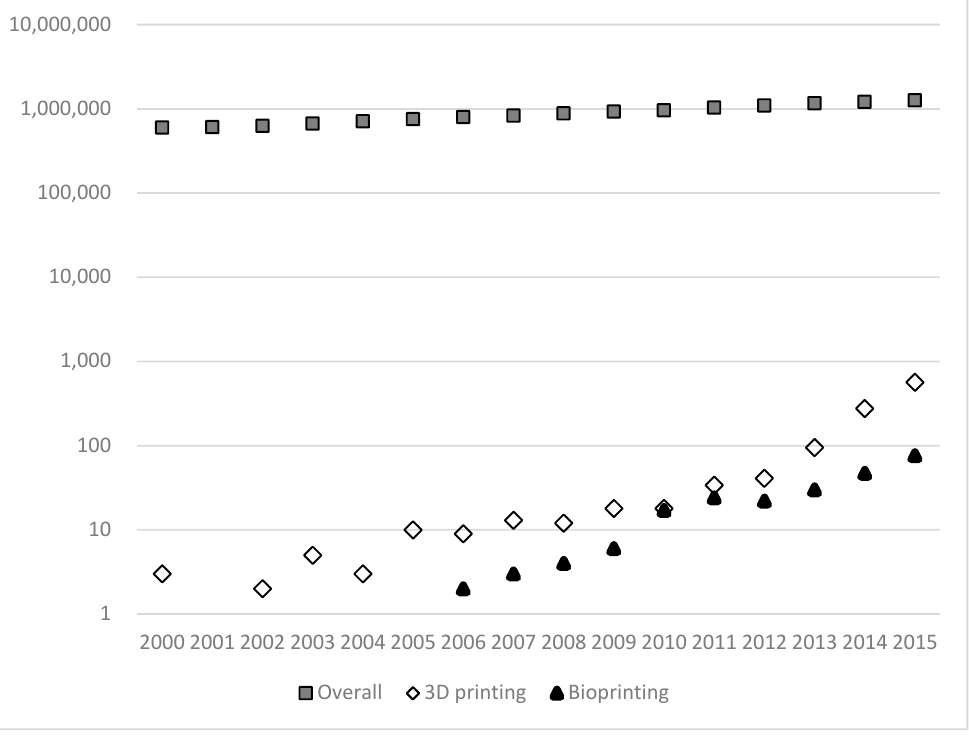
Figure 1. Trends of publication productivity in the scientific literature involving “3D printing” and “bioprinting” from 2000 to 2015 (articles and reviews published in English). Overall: scientific literature.